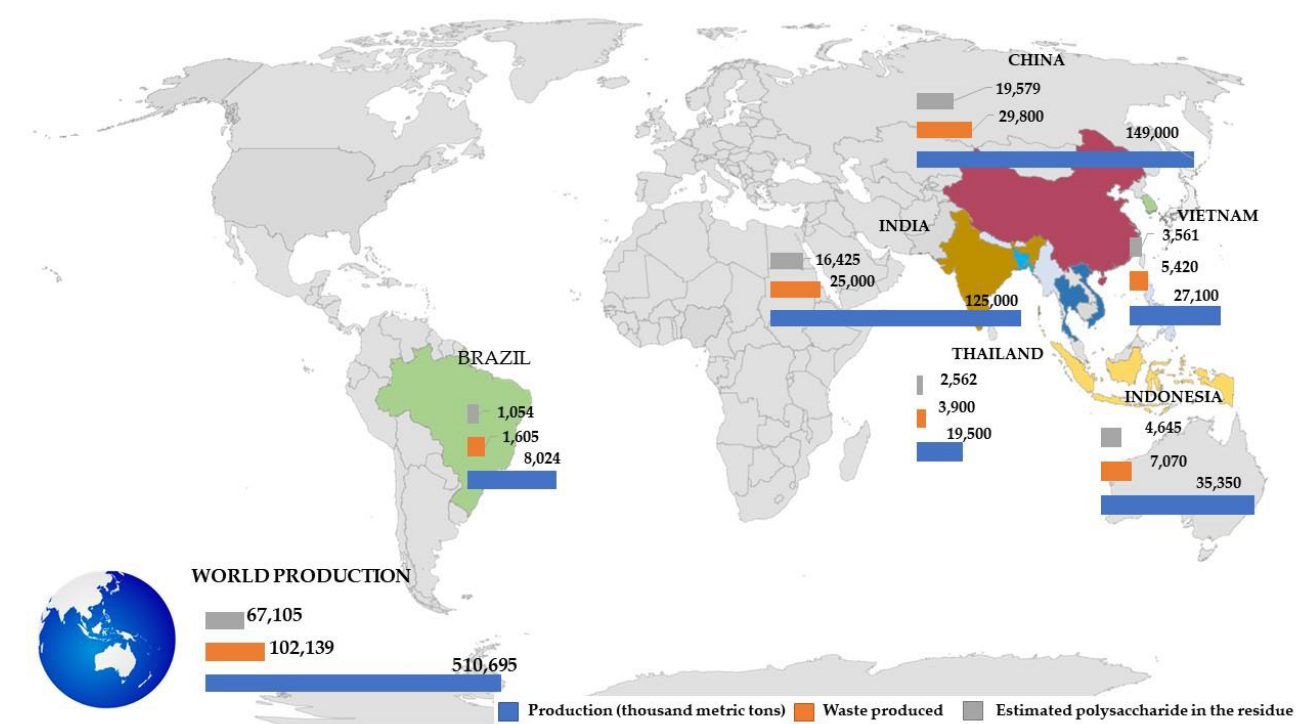
Figure 5. Main global producers of rice in the year of 2020–2021: total production (in thousand metric tons, blue bars), waste production (orange bars), and estimated polysaccharide residues (gray bars).